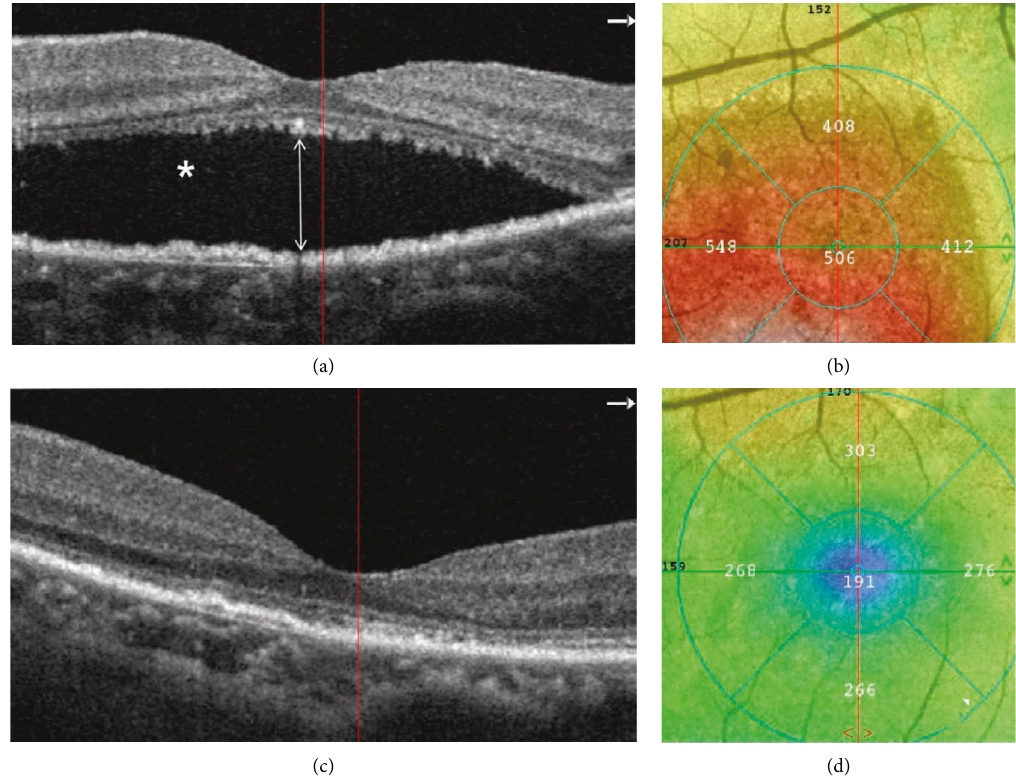
Figure 2: Representative image of the patient with CSCR showing CMTreduction and SRF resolution after anti-VEGF treatment. An 49- year-old female with CSCR. Her initial BCVA (logMAR) was 0.30, which was improved to 0.05 after 3 consecutive intravitreal injections of aflibercept. (a) OCTA image (3 ∗ 3 mm 2 ) showed the presence of SRF (asterisk) and the height of SRF (double-head arrow); (b) The CMT before treatment was about 506 μ m; (c) Complete resolution of SRF after three anti-VEGF treatments. (d) The CMTwas about 191 μ m after the final follow-up.